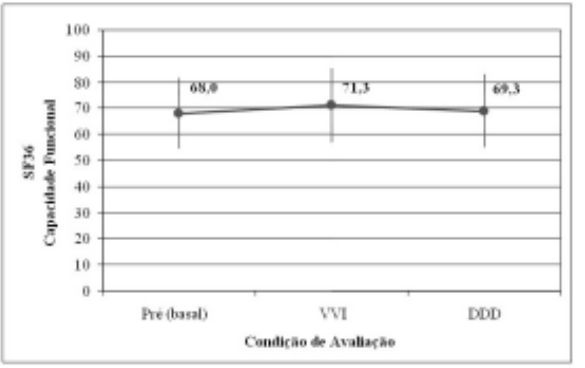
Fig. 2 - Qualidade de vida avaliada pela capacidade funcional (p=0,489) nas condições Pré (basal), VVI e DDD, dos pacientes com cardiopatia chagásica e bloqueio atrioventricular. Total de pontos (SF36) da avaliação da capacidade funcional, representados em média e desvio-padrão; DDD: condição do paciente após 90 dias de estimulação atrioventricular; p: nível descritivo do teste de variância para medidas repetidas; Pré (basal) condição do paciente em estimulação ventricular exclusiva na seleção do estudo; VVI: condição do paciente após 90 dias de estimulação